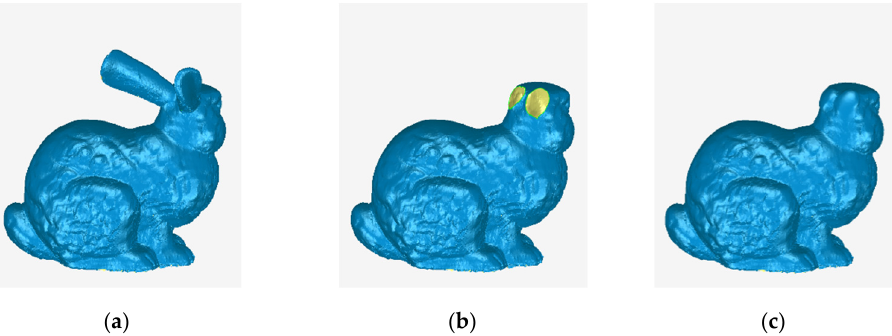
Figure 1. An example of point cloud data with sharp features: ( a ) The complete point cloud data; ( b ) The point cloud data with sharp features; ( c ) The reparative data using curvature.